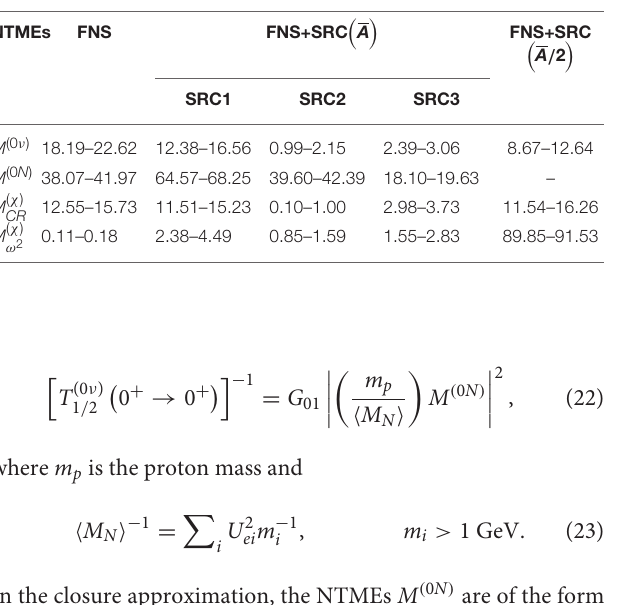
TABLE 4 | Relative changes (in %) in NTMEs M (0 ν ) , M (0 N ) , M ( χ ) CR , and M ( χ ) calculated with four different parametrizations of the effective two-body interaction due to the inclusion of FNS, FNS+SRC (FNS+SRC1, FNS+SRC2, and FNS + SRC3), and average energy denominator A /